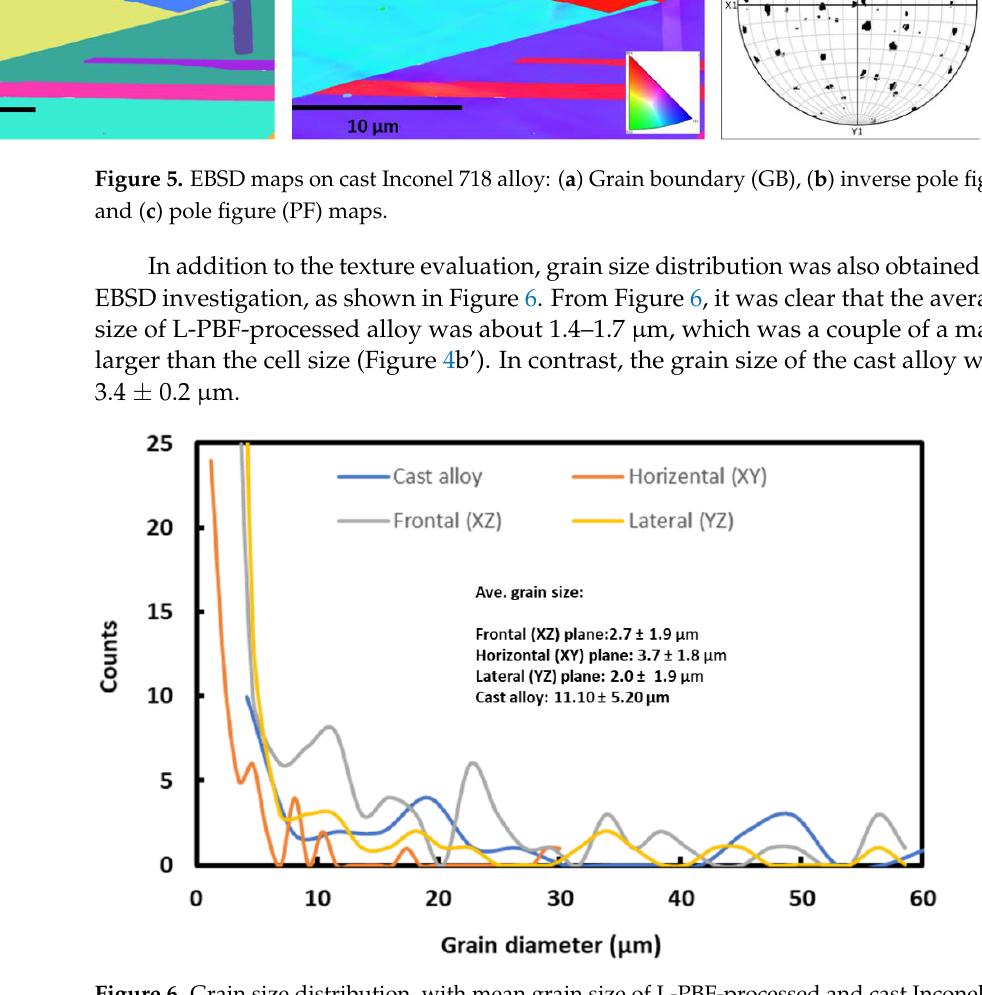
Figure 6. Grain size distribution, with mean grain size of L-PBF-processed and cast Inconel 718 alloy, as determined from EBSD data analysis.